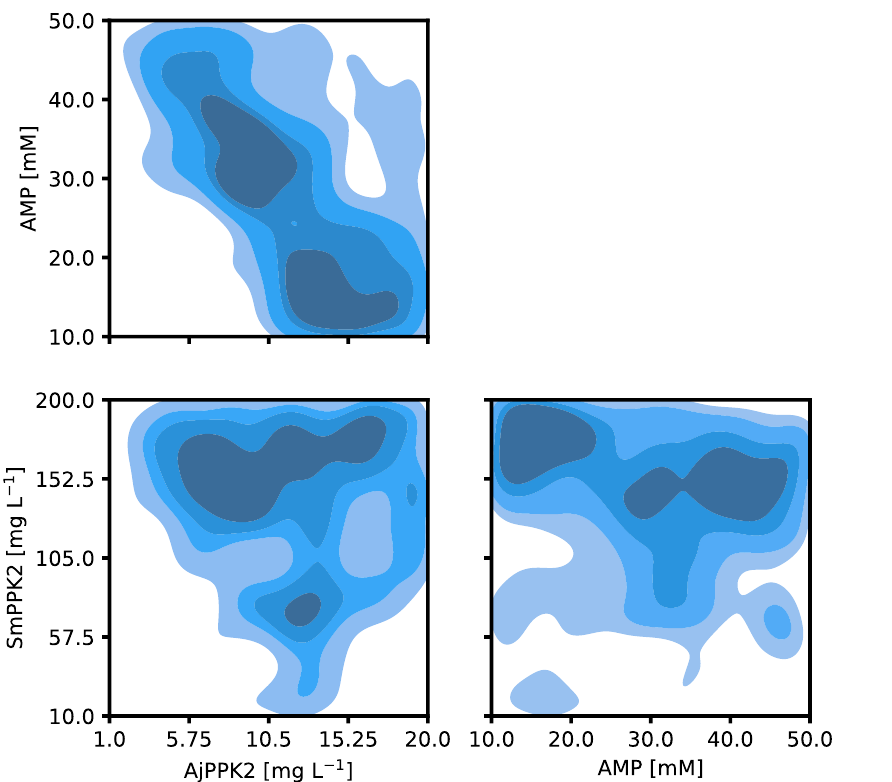
Figure 3. Probability density of the optimal initial concentrations of the reaction components AMP, A j PPK2, and S m PPK2. The contours encode the probability mass for the experiment conditions corresponding to the maximum specific activity derived from 10,000 samples of the final GPR model. Each shade encodes 20% of the cumulative probability mass.